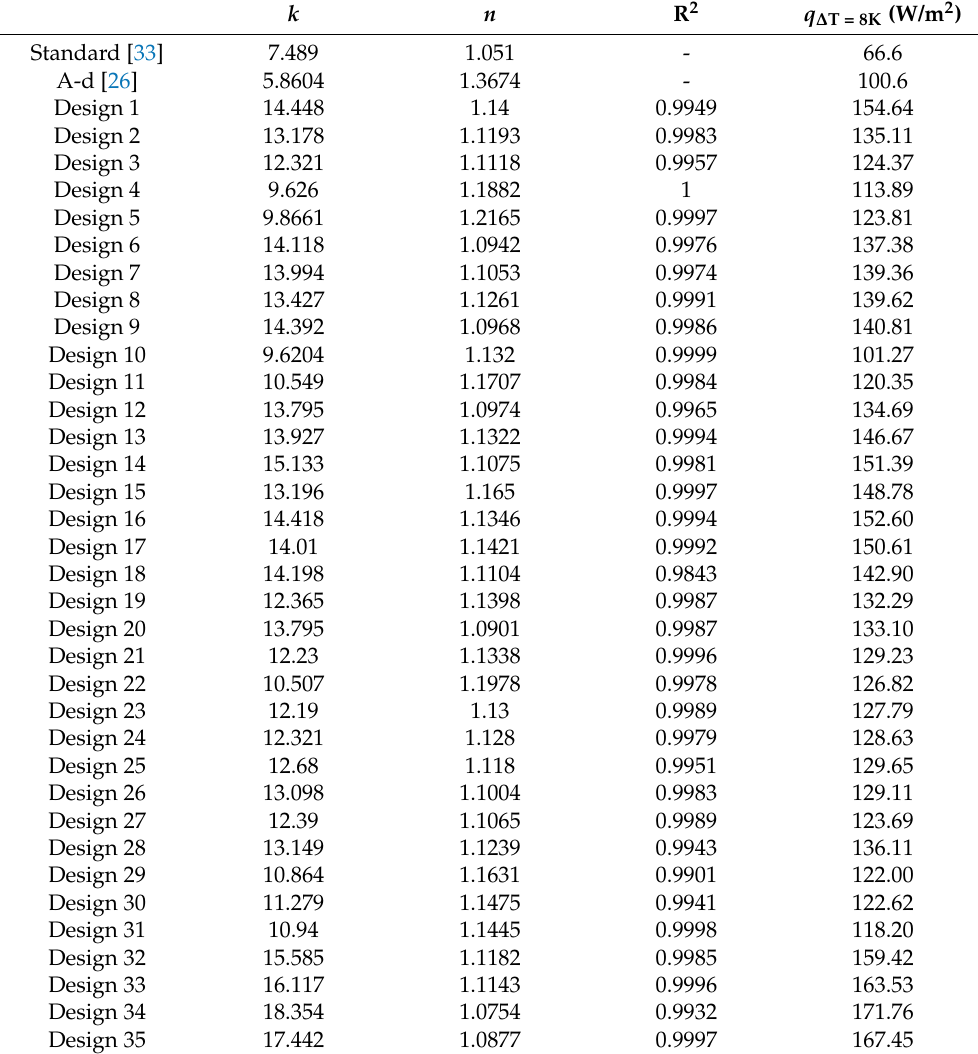
Table A1. Coefficient for nominal cooling capacity